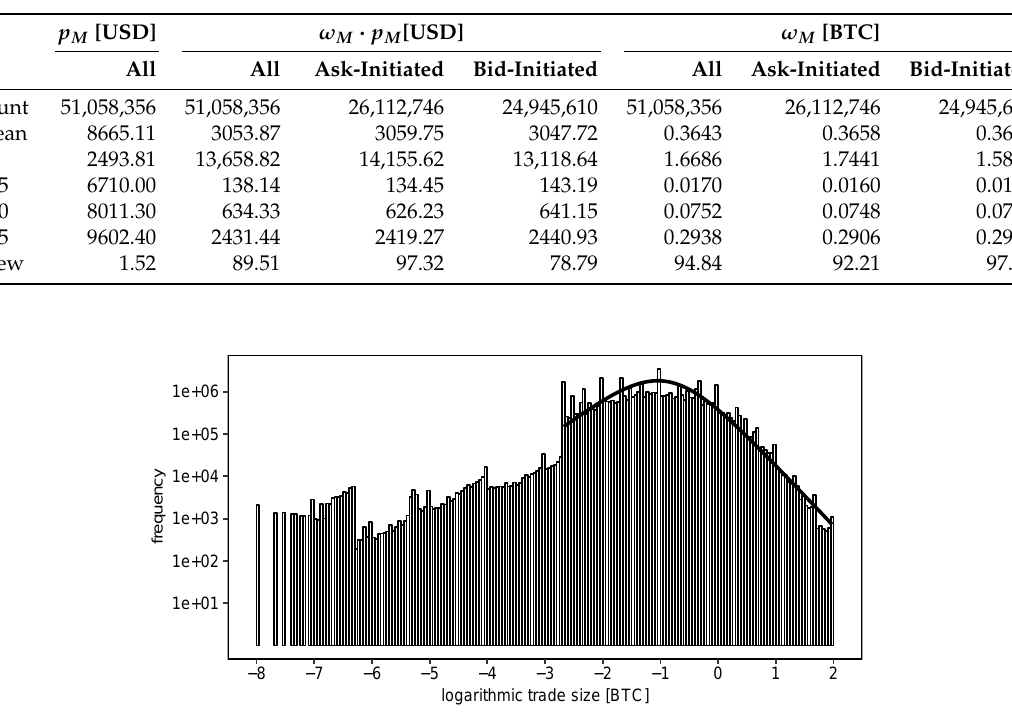
Table 9. Descriptive statistics of trades. This table lists descriptive statistics of the price p M , the value ω M · p M and the size ω M for all trades.